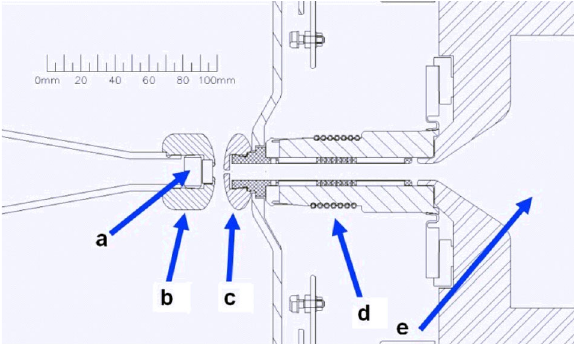
FIG. 13. Close-up view of the electron source with (a) insert for holding the Nb 3 Sn wire, (b) hollow cathode, (c) anode, (d) pulsed solenoid with drift distance, and (e) rf cavity.